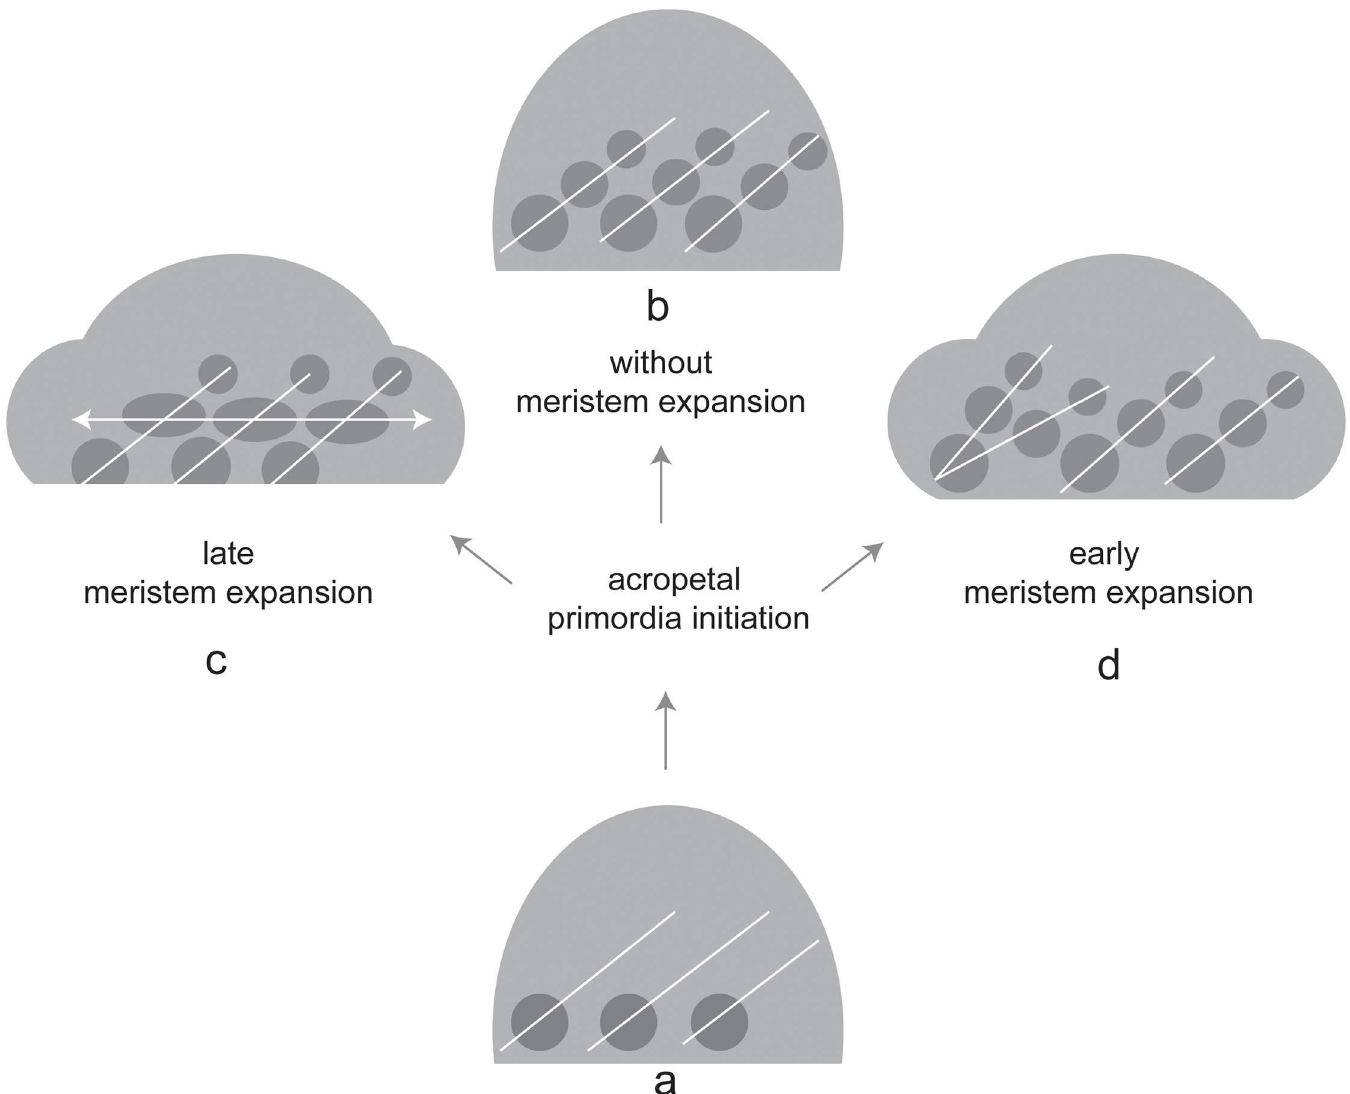
Fig 5. Schematic diagram illustrating the putative effectsof early and late meristemexpansion on flower initiation. (a) The head meristem fractionates flower primordiain an acropetal direction(white lines). (b) If the geometry of the head does not change,regular parastichies appear. (c, d) If the meristem expandsin its middlepart, spatial conditions change.Depending on the time of expansionrelativeto the time of primordiainitiation,alreadyexisting primordia are promoted(c) or additionalparastichies are formed (d).